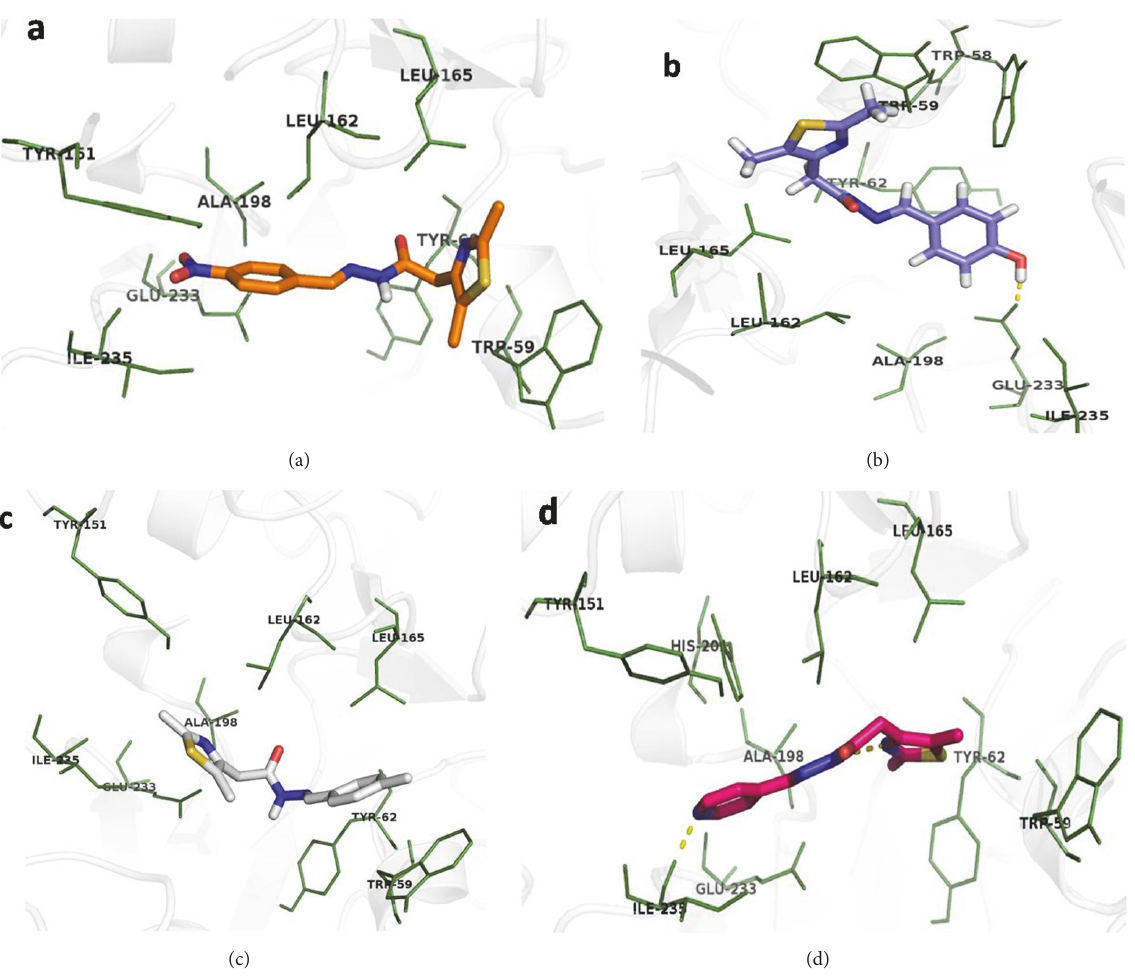
Figure 1: Binding modes on the amylase active site of top four compounds ( 14, 10, 1, and 20 ) by molecular docking study.